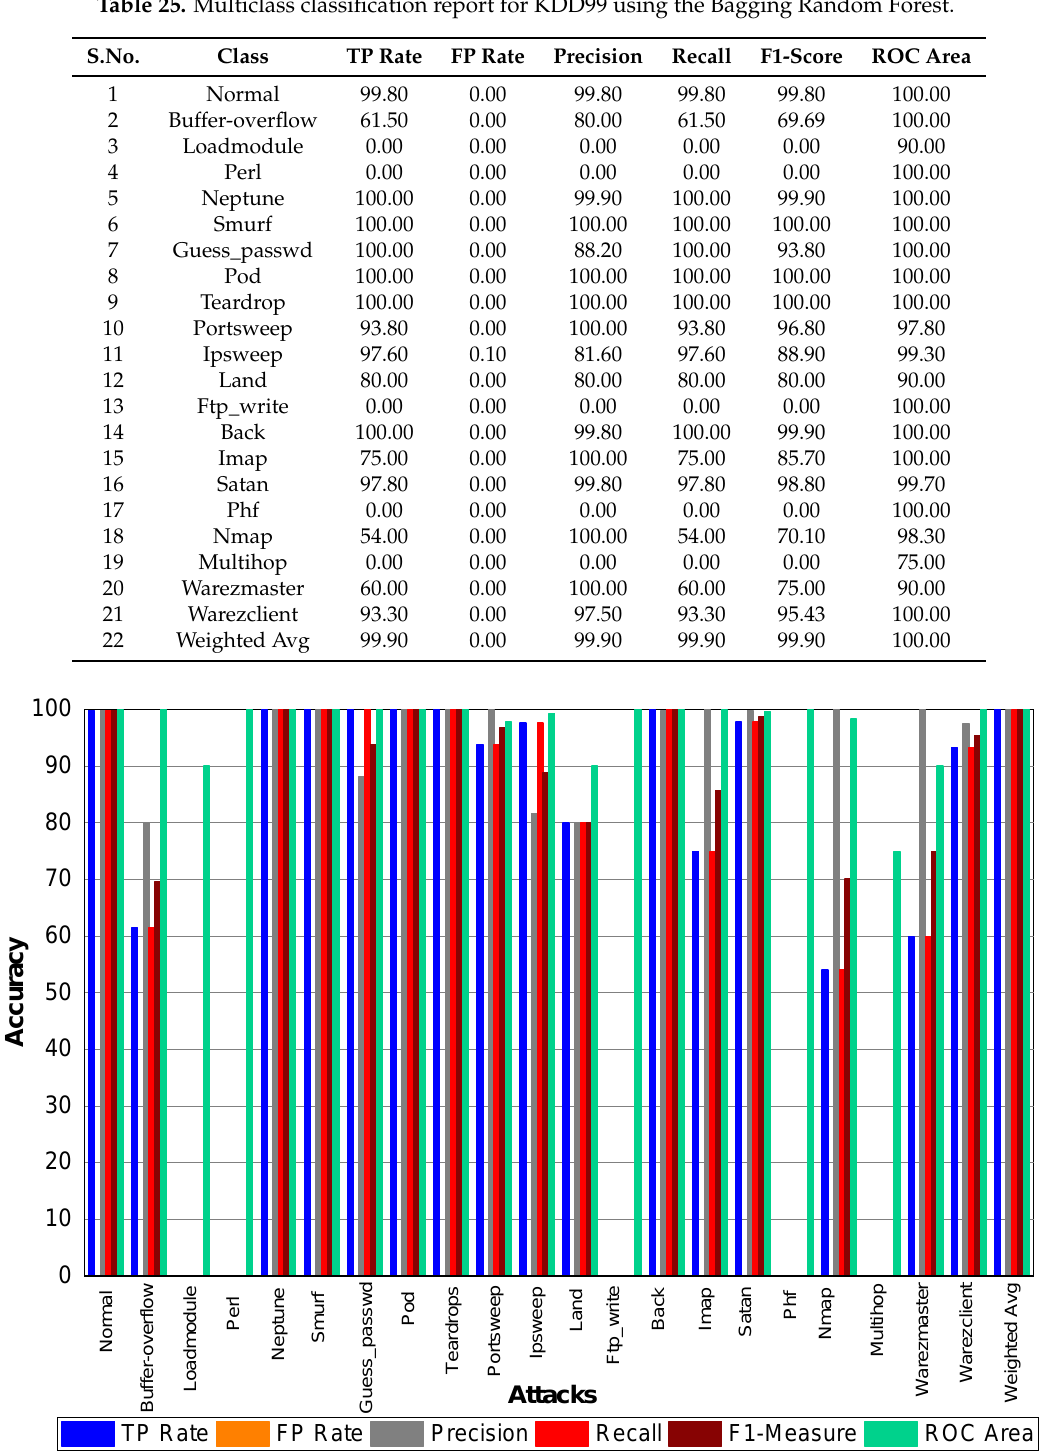
Table 25. Multiclass classification report for KDD99 using the Bagging Random Forest.